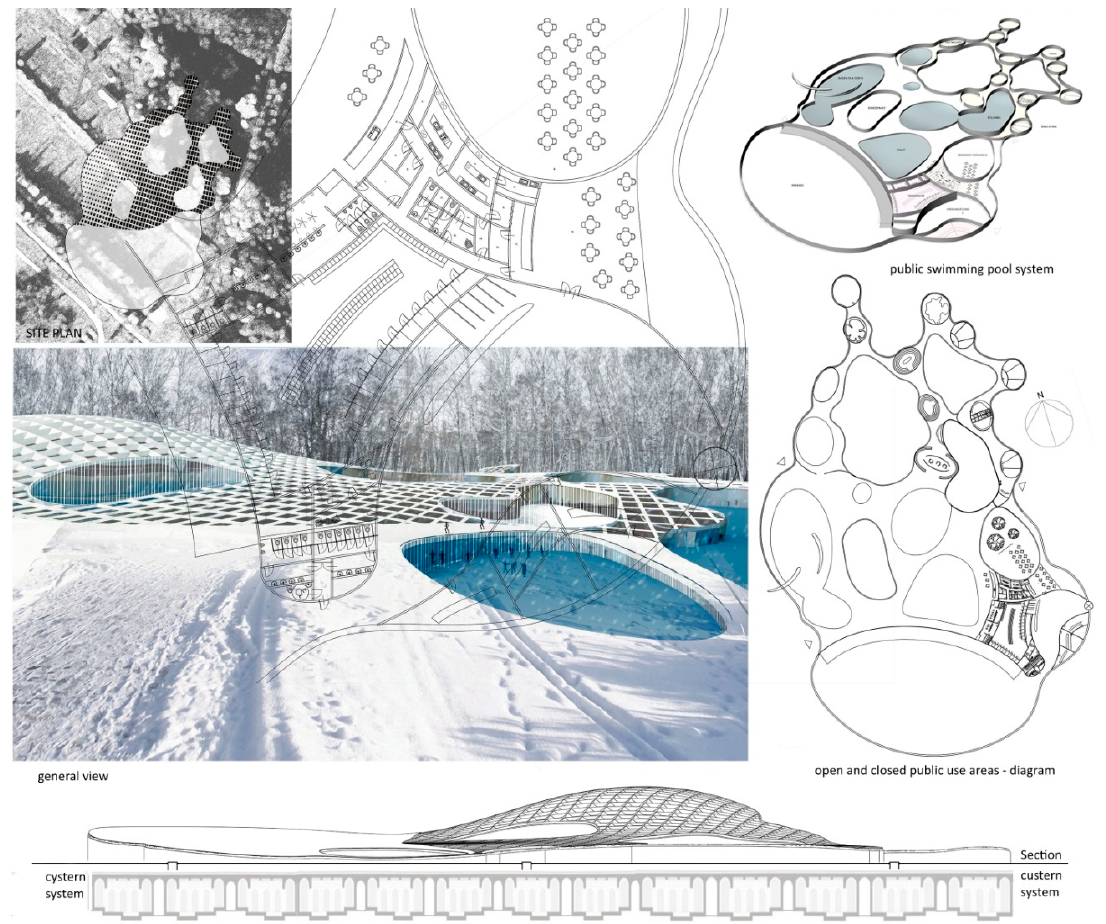
Figure 7. Flood prevention and leisure—concept design development (Katarzyna Dobrowolska).